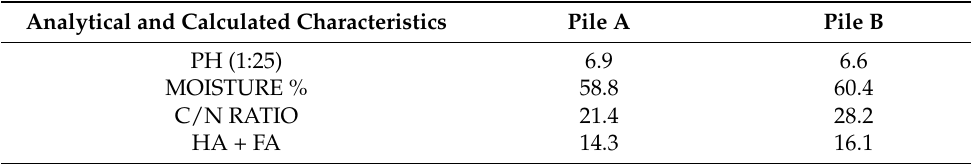
Table 4. Analytical and calculated characteristics of the initial composting mixtures. Analytical and Calculated